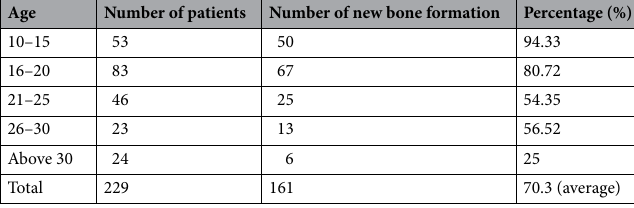
Table 3. New bone formation in different age distributions of